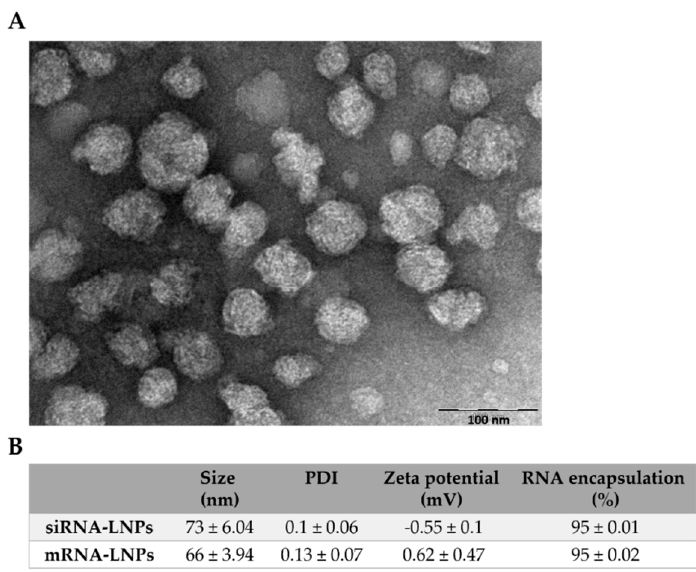
Figure 1. Physicochemical and structural characterization of lipid nanoparticles (LNPs). ( A ) A representative (transmission electron microscopy) TEM image of RNA-encapsulating LNPs. ( B ) Table